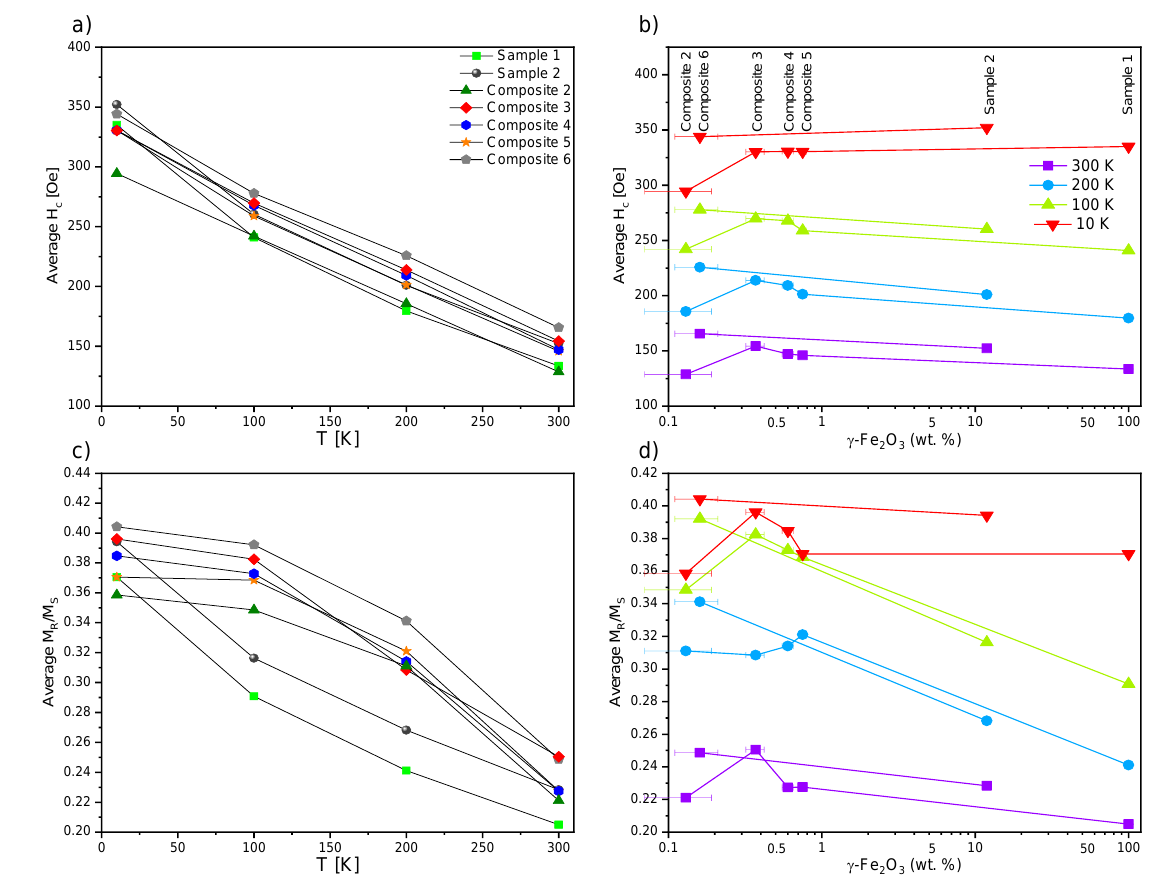
Figure 18. Temperature ( a ) and estimated weight percent (wt %) of the γ -Fe 2 O 3 nanoparticles ( b ) dependencies of the average coercive field, and temperature ( c ) and estimated γ -Fe 2 O 3 wt % ( d ) dependencies of the average remanence ratio (remanent magnetization M R /saturation magnetization M S ) for Samples 1 – 2 and Composites 2 – 6. The solid lines in all figures are a guide for the eye. The legend in graph ( a ) is the same for graph ( c ), while the legend in graph ( b ) is the same for graph ( d ).